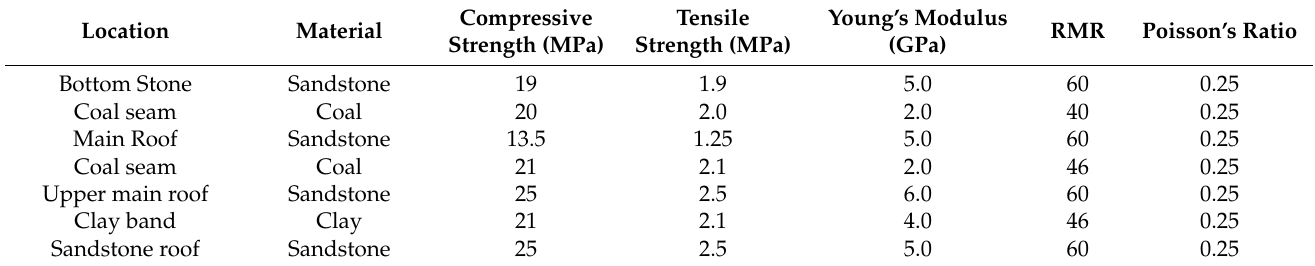
Table 2. Physicomechanical properties assigned to the rock